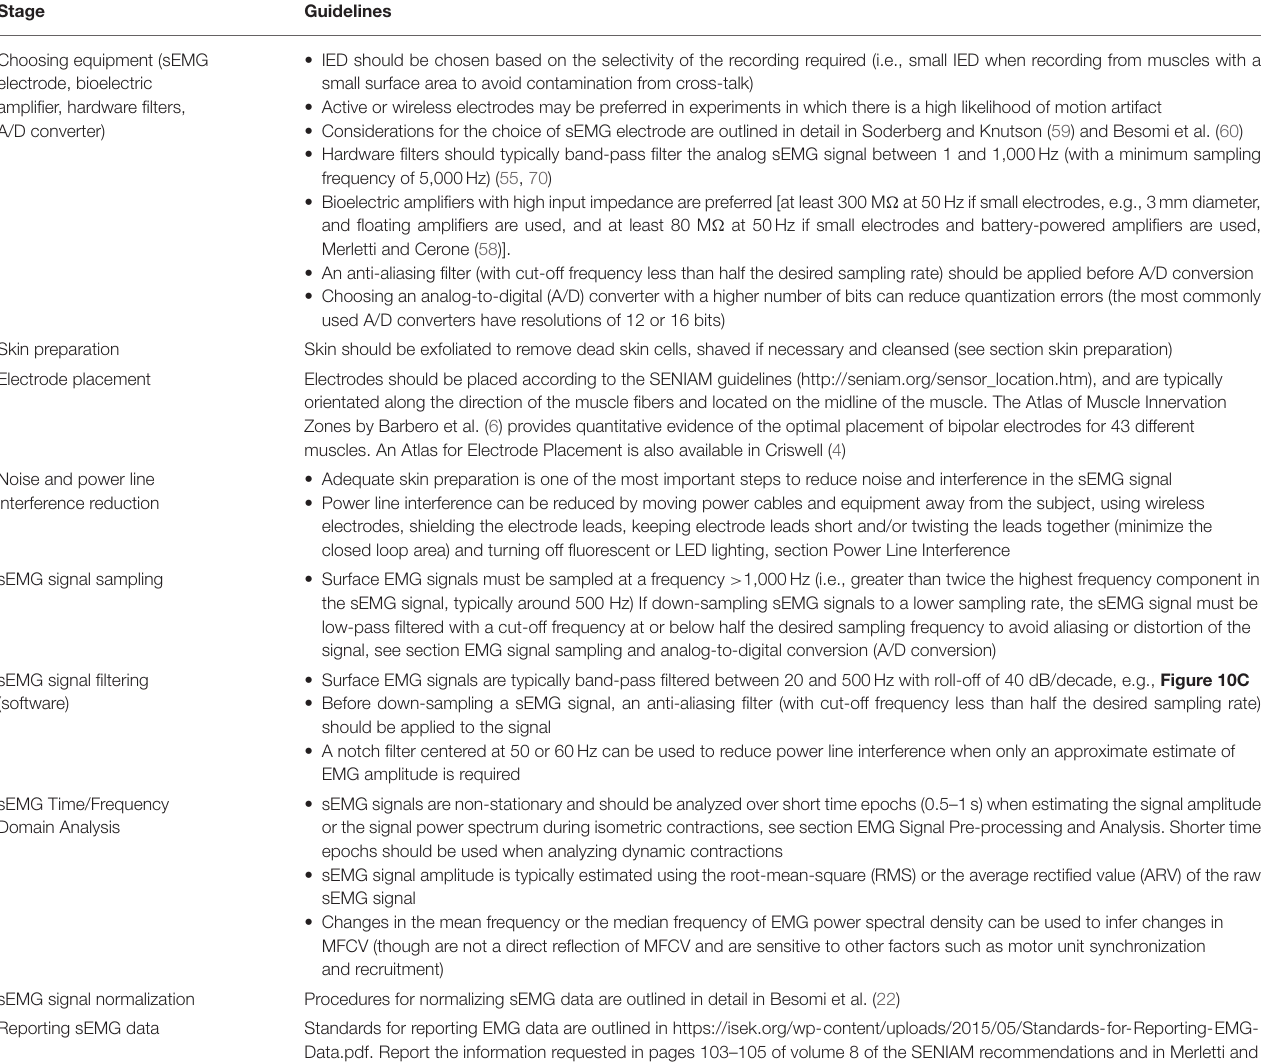
TABLE 2 | Summary of sEMG